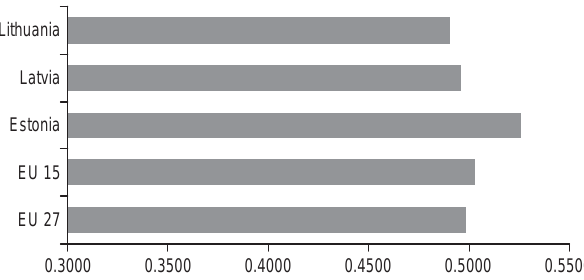
Fig. 1. Aggregated assessment of Baltic countries in the EU context during the averaged period of 2004–2008 (the fi rst situation). Data source: Eurostat, Transparency international, The Heritage Foundation, computed by authors